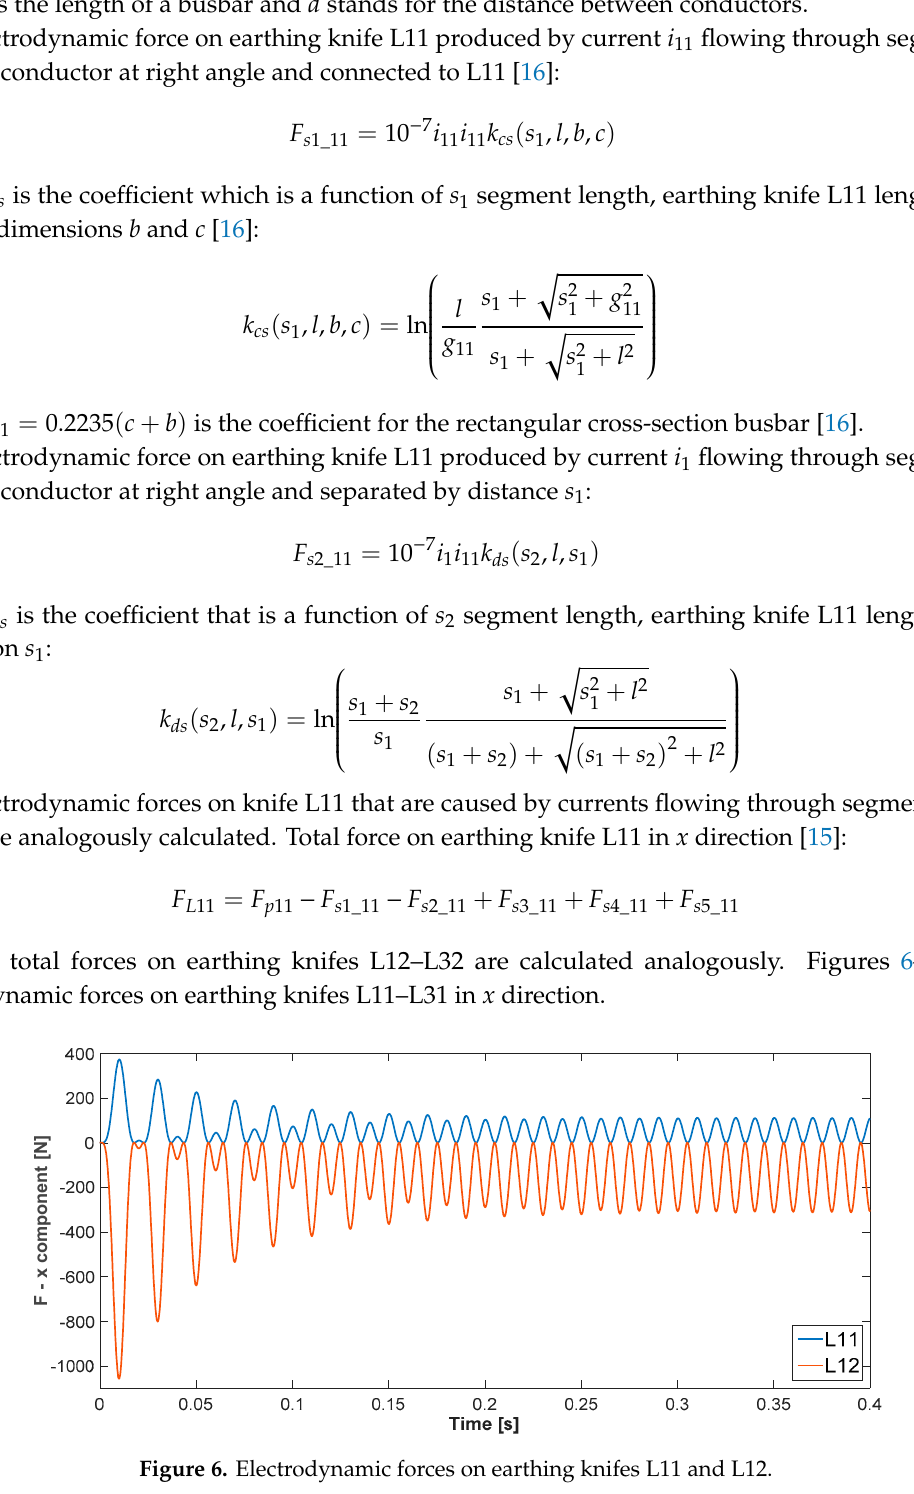
Figure 7. Electrodynamic forces on earthing knifes L21 and L22. Figure 8. Electrodynamic forces on earthing knifes L31 and L32. Table 3. Maximum forces on knifes in transient and in stationary state. Knife